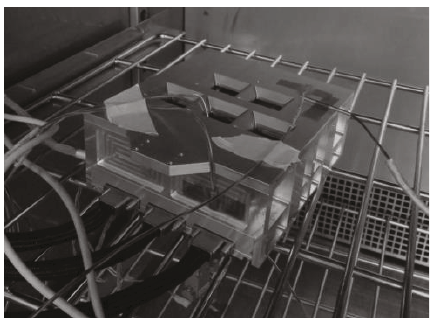
Figure 14: Thermal test condition of the focal plane.